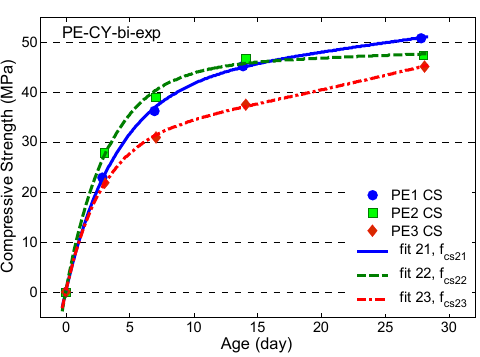
Figure 9. Compressive strength modelled by using bi ‐ exponential regression.